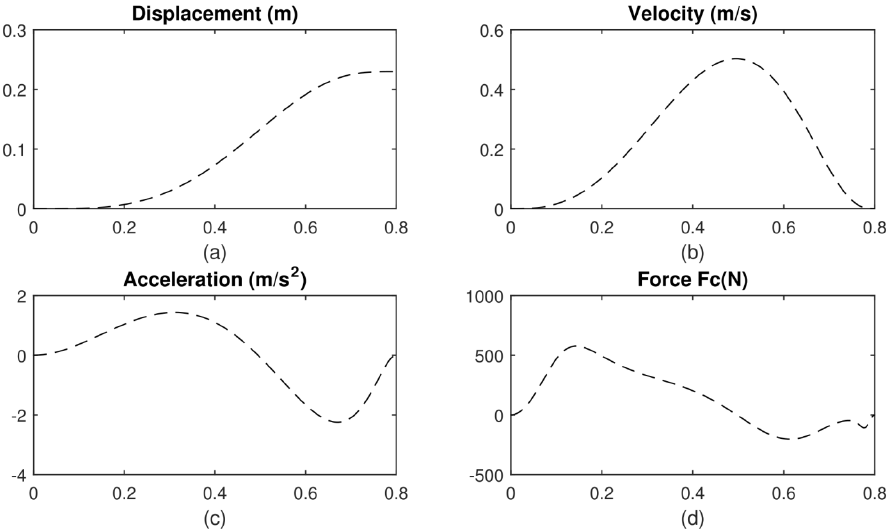
Figure 7. ( a – d ) The displacement, velocity, acceleration, and force on slider C, respectively, which all change over